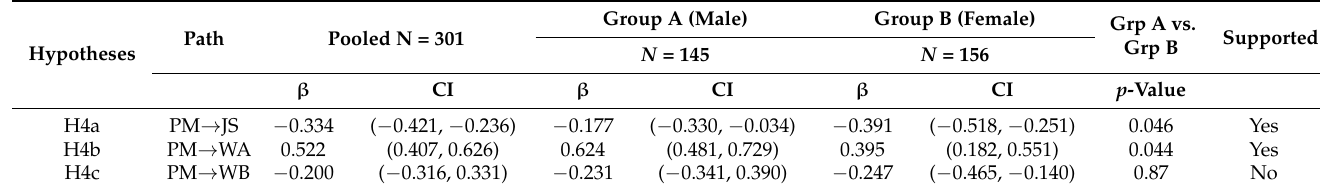
Table 7. Multi-group analysis